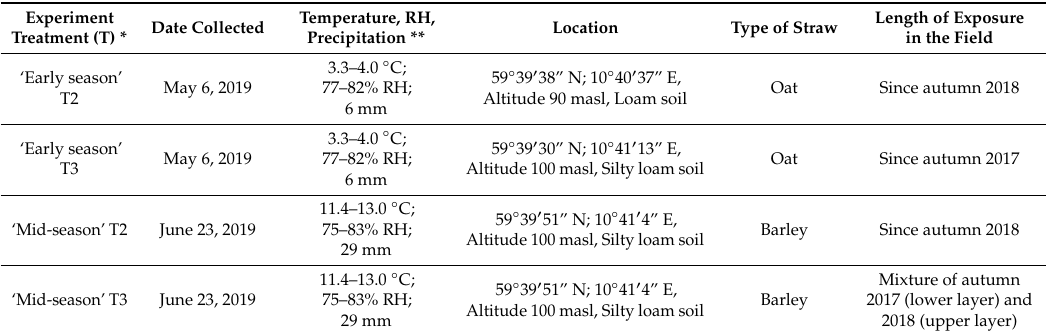
Table 1. Details of the di ff erent types of straw used in the study and the fields from which they were collected. All fields belonged to the same grower (County of Viken) in SE Norway. RH = Relative